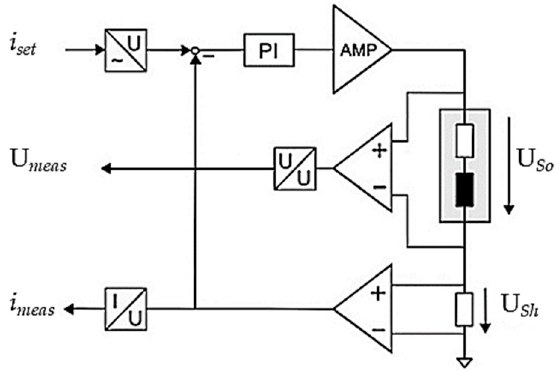
Figure 6. Schematic Depiction of the Mechanical Setup for Measuring Solenoids. On the left, the Solenoid to be Measured.